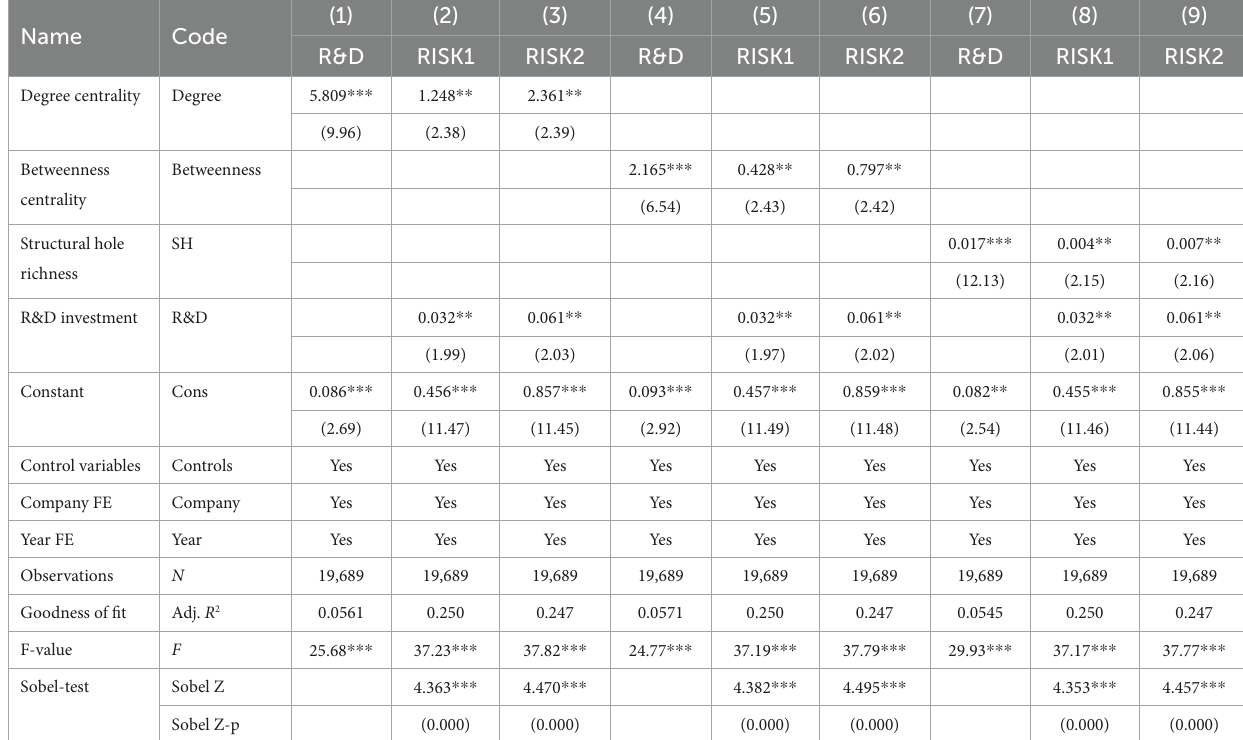
TABLE 10 Results of the mediating effect of